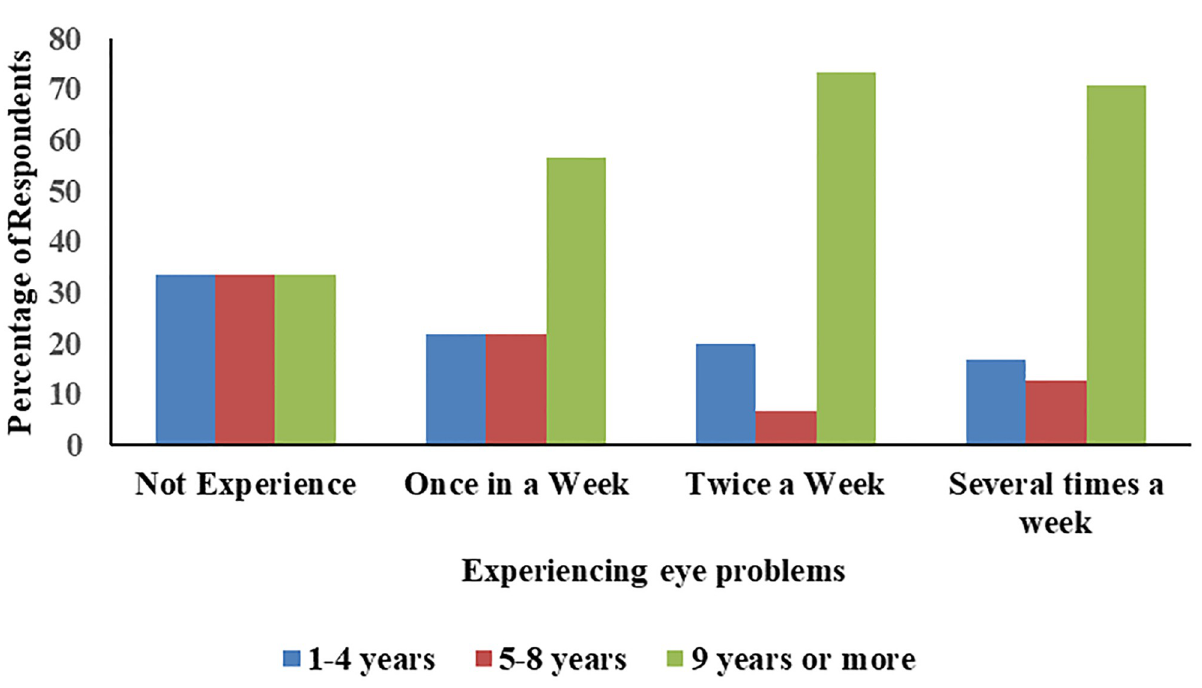
Fig 7. Frequency of eye problems and the number of years spent smoking.